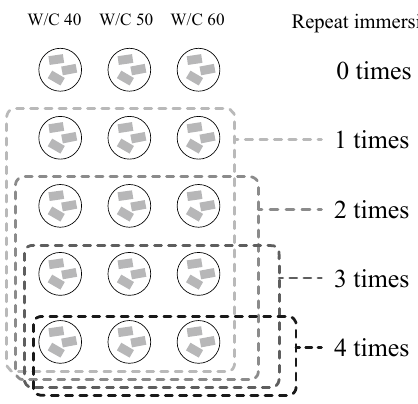
Figure 1. Repeated mortar specimen immersion method.